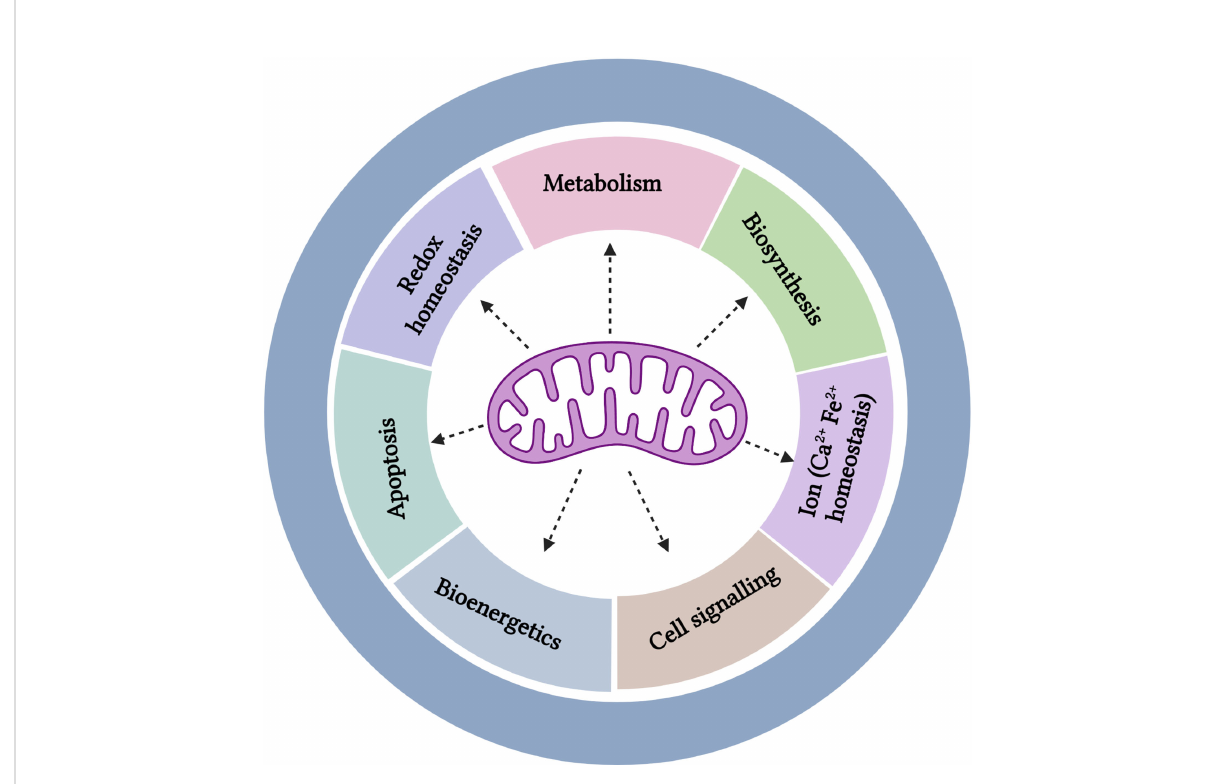
FIGURE 2 Multifaceted roles of the